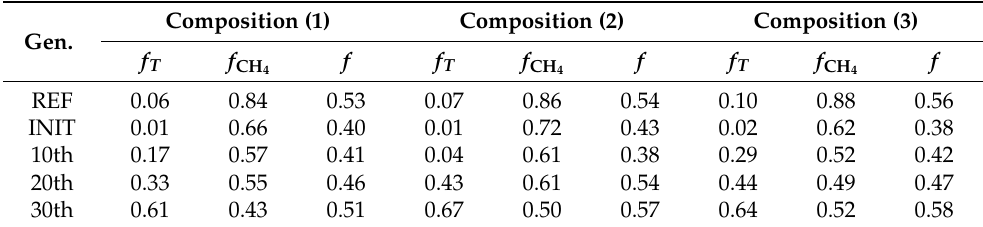
Table 5. The amount of catalyst used in comparison with the reference cases. Gen.